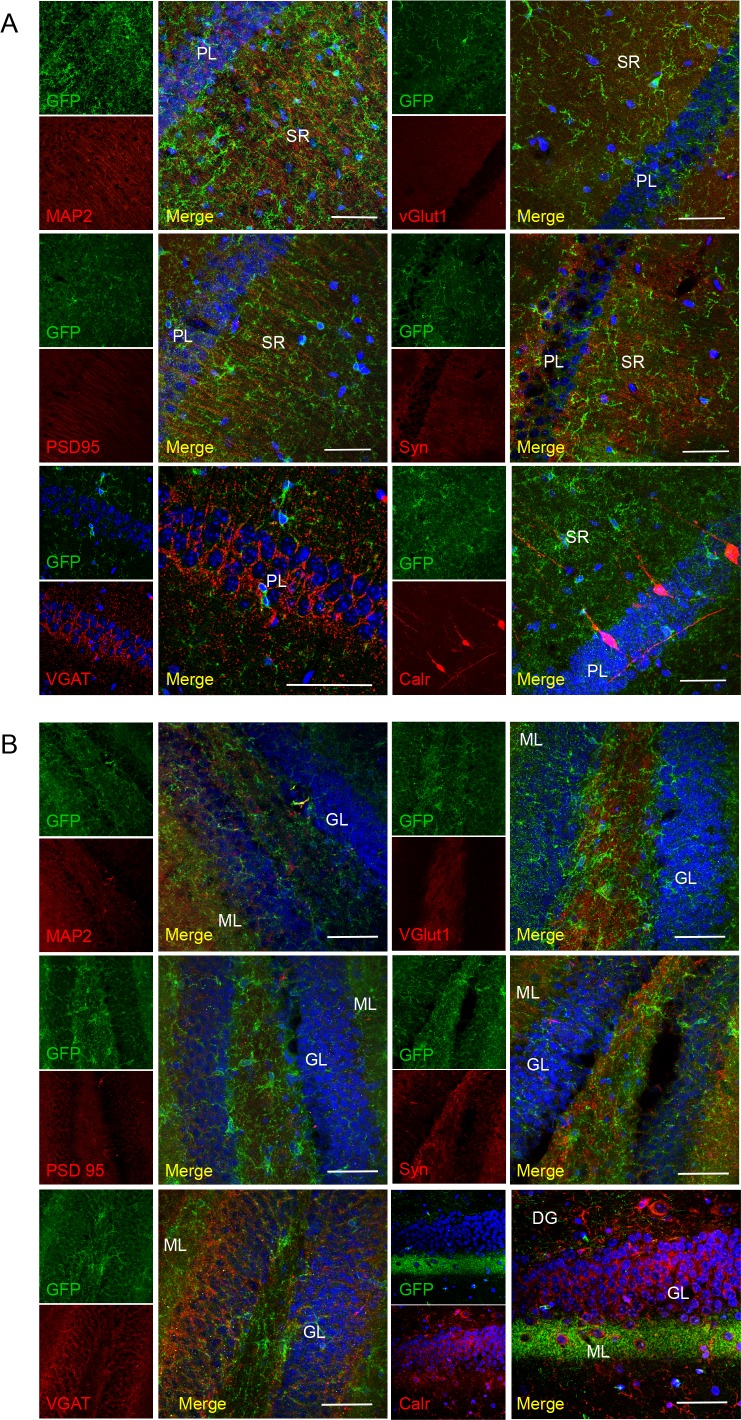
No co-localization of P2X7-EGFP with neuronal/synaptic markers in the CA1 region(A) and dentate gyrus (B). Co-labeling with antibodies against GFP (green, ab6556, Abcam), different neuronal or synaptic marker proteins (red), and DAPI (blue). Scale bars: 50 μm, n = 3 animals.